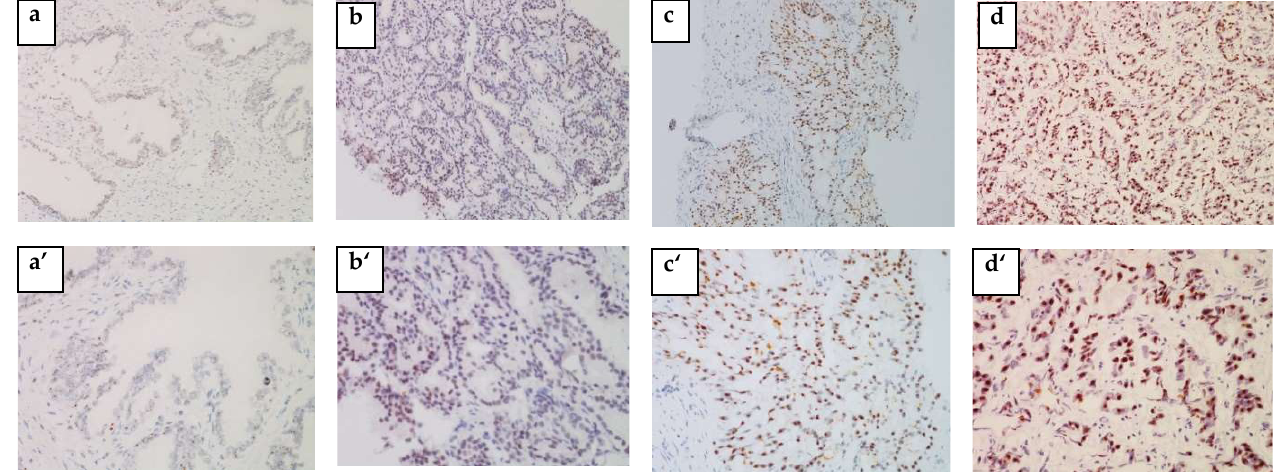
Figure 3. Menin expression is associated with aggressive human PCa. Representative tissue sections of PCa tumors from needle biopsies were stained for IHC specific for Menin. ( a , a’ ) BPH, ( b , b’ ) weakly positive (non-aggressive PCa), ( c , c’ ) moderately positive (moderate PCa) and ( d , d’ ) strongly positive (aggressive PCa). ( a – d ) × 200 and ( a’ – d’ ) × 400